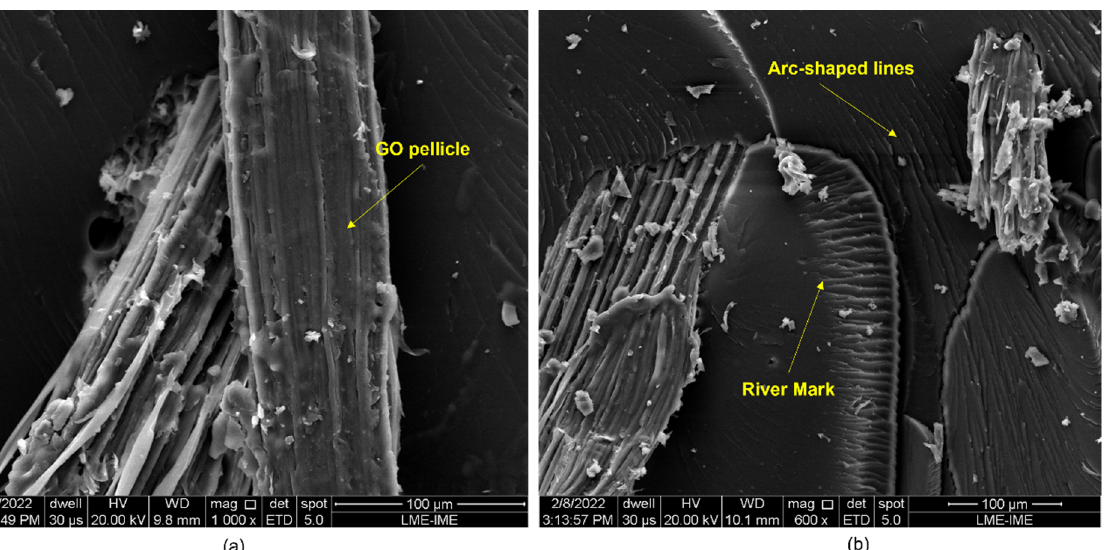
Figure 11. Fracture surface of a bidirectional composite with 30 vol.% fibers (PGO/ENT) at 300× ( a ) and 600× ( b ) magnifications.